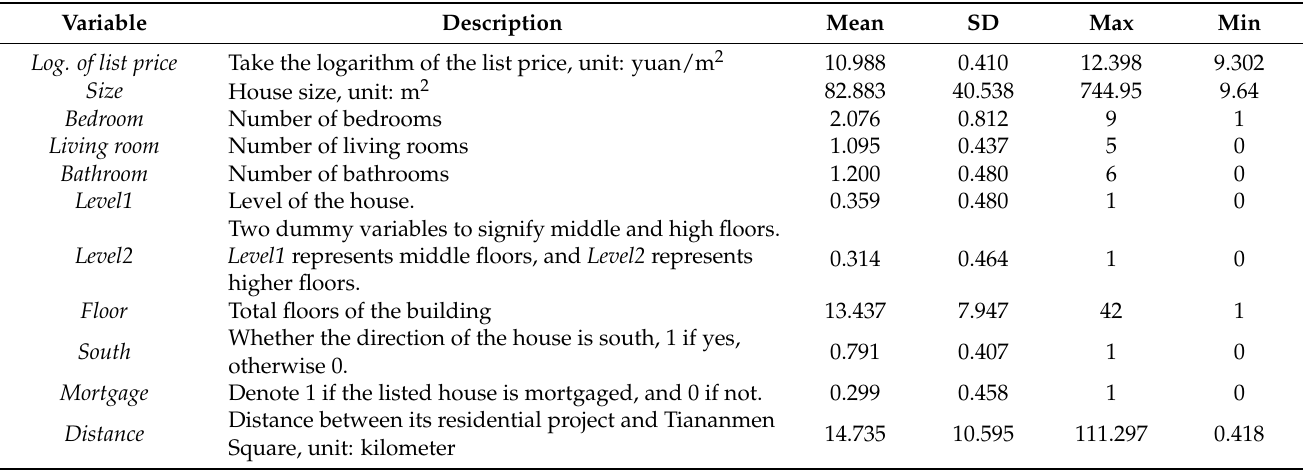
Table 2. Listing data and descriptive statistics.